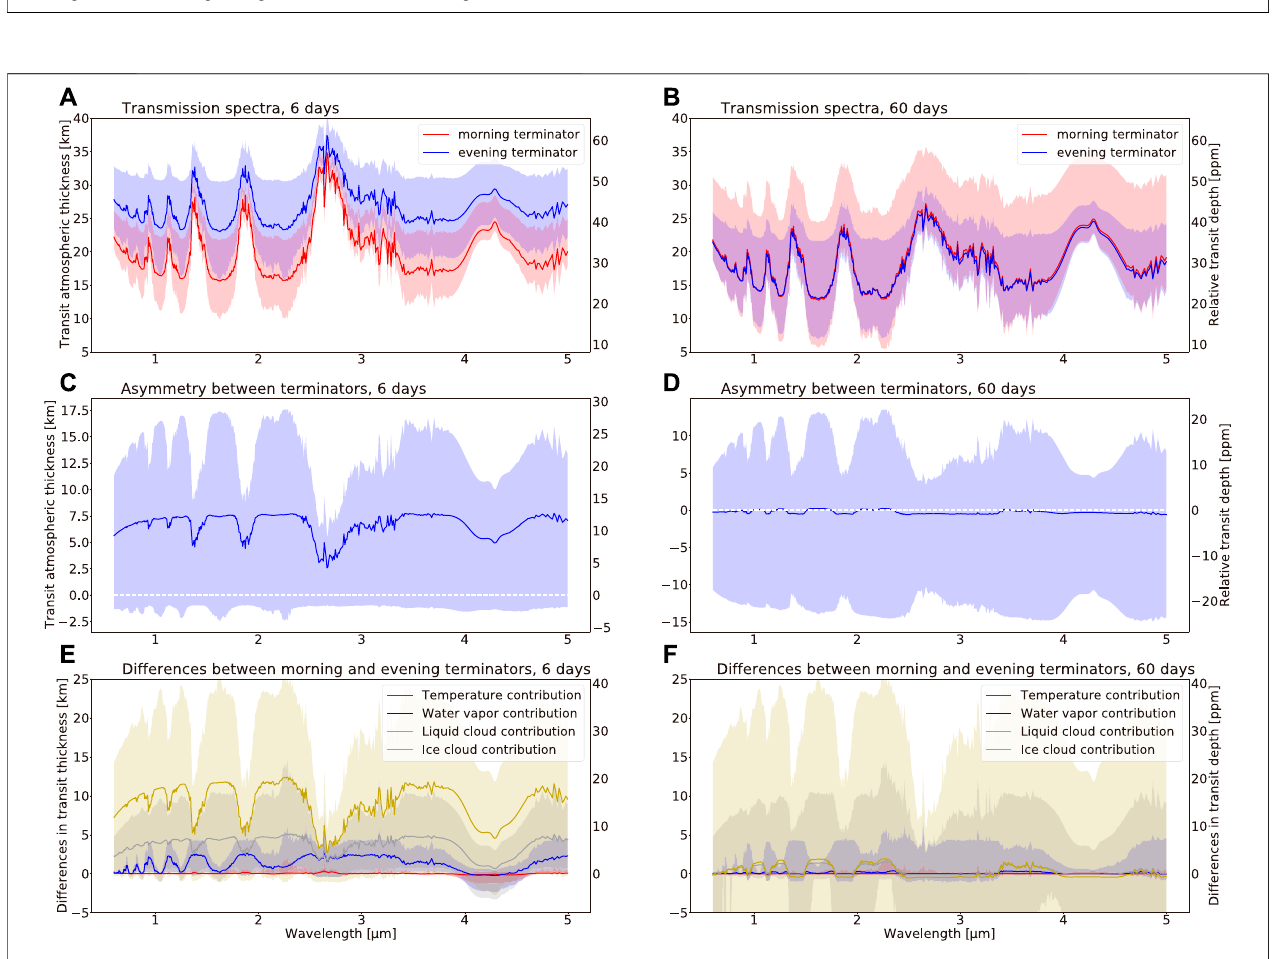
FIGURE2| Transmissionspectraandtheirvariabilityoftidallylockedplanets,from0.6to5 μ m.Thelefty-axisisthetransitatmosphericthickness(km)andtheright y-axis is the relative transit depth (ppm). (A) , (C) , and (E) : results for planets with a rotation period of six Earth days ( (cid:1) orbital period); (B) , (D) , and (F) : for planets with a rotationperiodof60Earthdays.In (A) and (B) ,thebluelineisfortheeveningterminatorandtheredlineisforthemorningterminator,andtheareasshadedwithpaleblue and pale red show their variability. In (C) and (D) , the blue line is for the average value of the asymmetry (evening minus morning), and the areas shaded with pale blue show their variability. In (E) and (F) , the contributions of air temperature, water vapor, liquid clouds, and ice clouds to the asymmetry (evening minus morning) are showninred,blue,gray,andyellow,respectively,andtheirvariabilityareshadedwiththecorrespondingpalecolors.Thesurfacepressureis1bar,includingonlyN 2 and H 2 O. Note thatthe summary ofthefour lines in thelowerpanel [such as (E) ] isnotexactlyequal tothedifference between theblue lineand the red lineinthe upper panel [such as (A) ]; this is mainly due to the overlaps among water vapor, liquid clouds, and ice clouds.